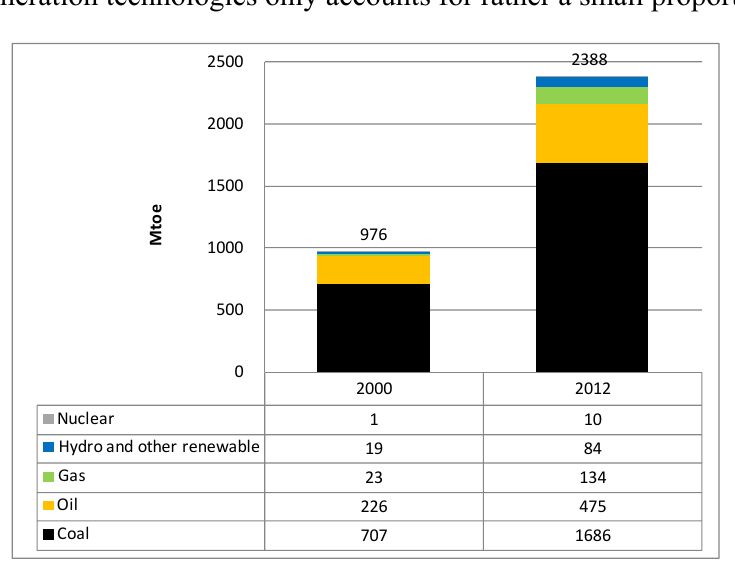
Figure 1. Energy consumption of China in 2012 [1]